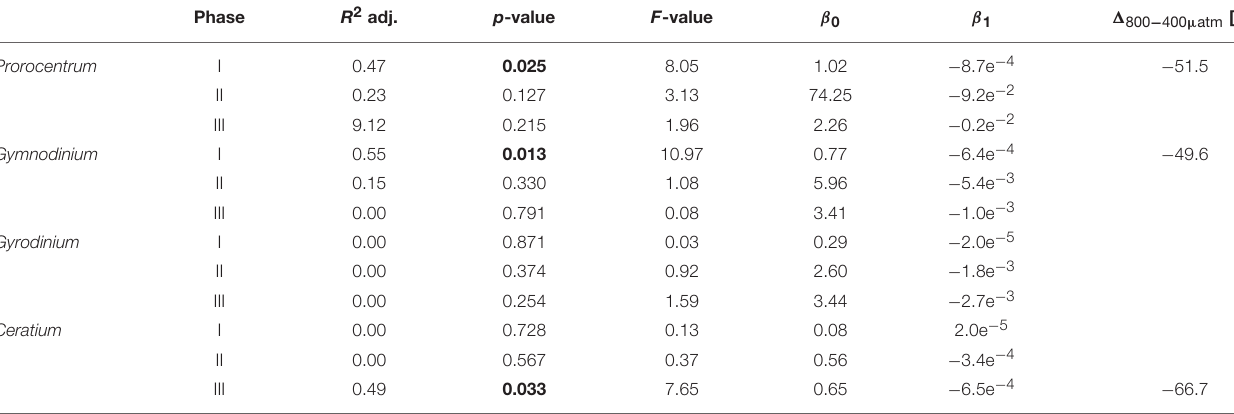
TABLE 5 | Results of linear regression for CO 2 effects on dinoflagellate species counted by light microscopy.